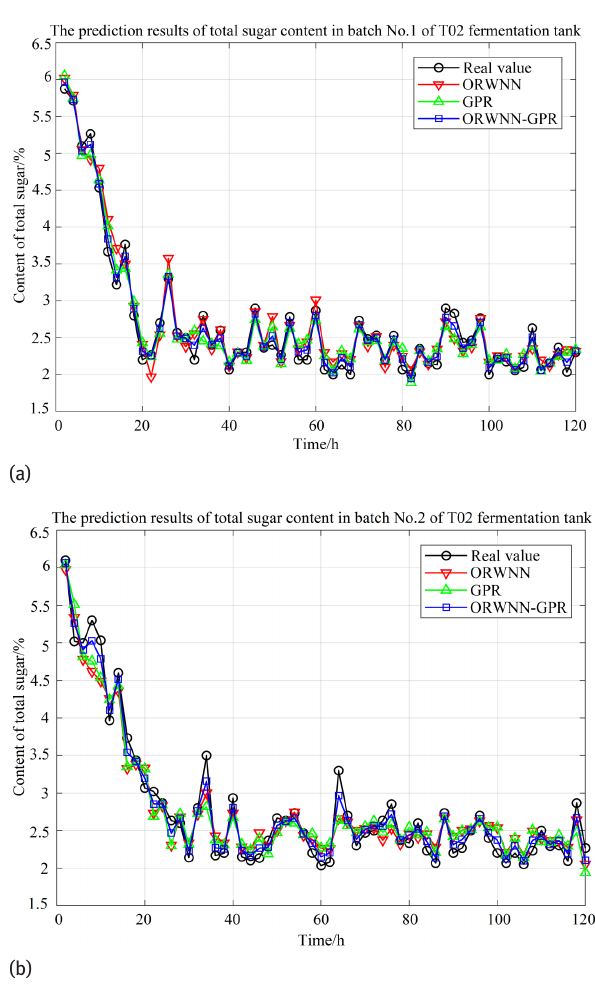
Figure 4: Comparison of total sugar content prediction results in two batches of T02 fermentation tank.